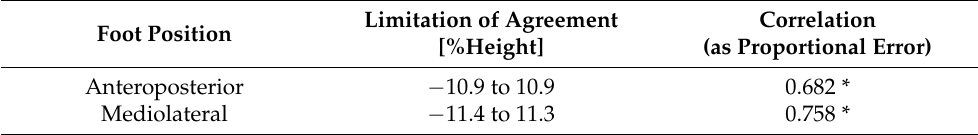
Figure 6. Bland–Altman plots between the proposed method and actual values. The proposed method used all wearable sensors and Gaussian process. (a) Anteroposterior foot distance; (b) mediolateral foot distance. Blue line: mean of difference; red line: limitation of agreement (LOA). %height is feet distance normalized to body height of each participant. Table 10. Statistical results for the Bland–Altman plots.